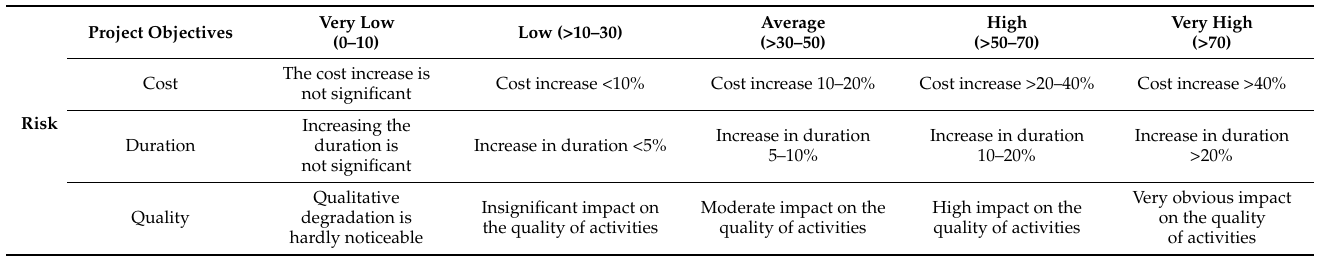
Table 7. Classification of risks based on the impact on project activities.